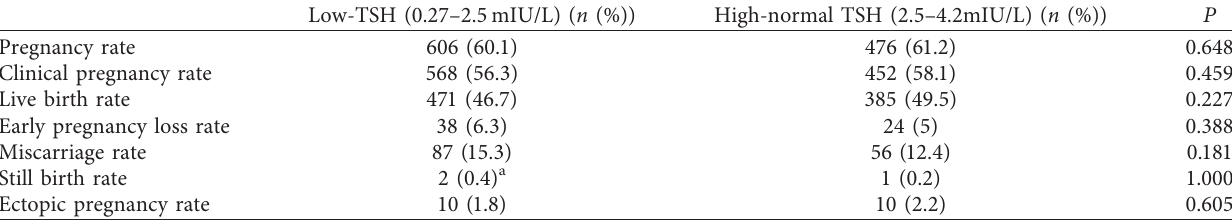
Table 2: Clinical outcomes after the first fresh D3 embryo transfer.